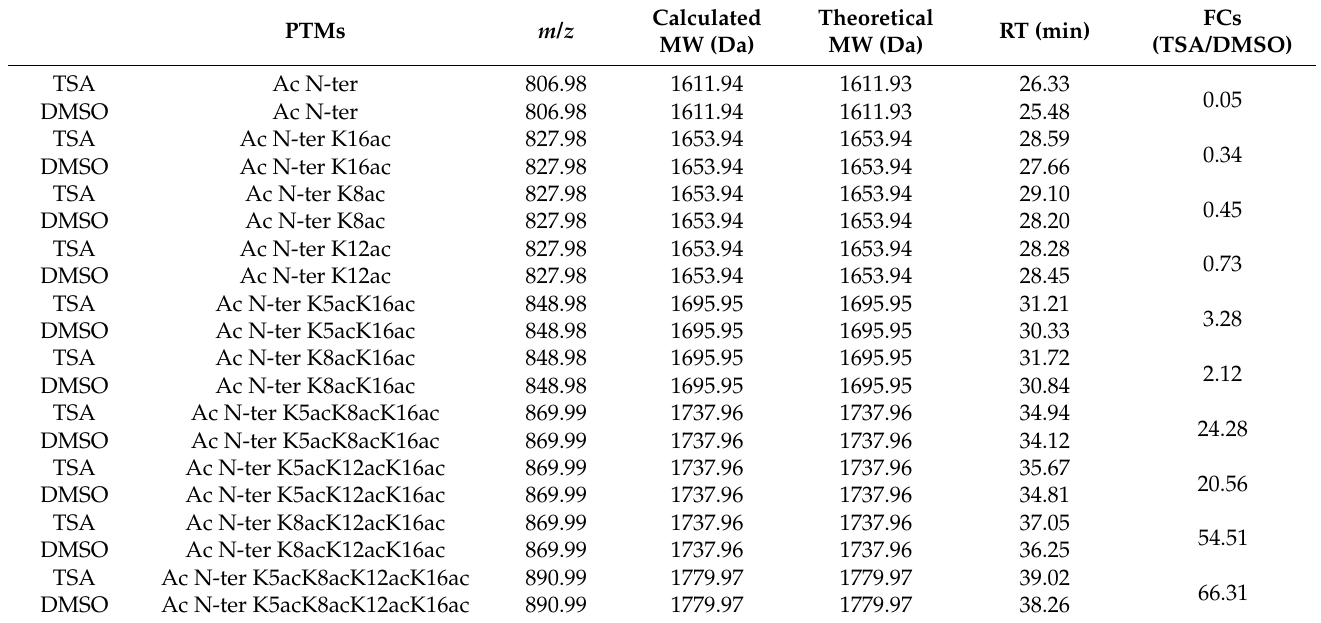
Figure 4. Extracted ion chromatogram (XIC) of selected peptides derived from histone H4 E14 ES mouse treated cells. The doubly charged 890.99 m / z signal corresponding to peptides 1–17 bearing five acetyl groups and reference peptides 46–55 are reported in DMSO- ( A ), and TSA ( B )-treated cells. The 869.99 m / z values relative to doubly charged peptides 1–17 carrying four acetyl groups are reported. ( C ) Extracted ion chromatogram recorded for DMSO-treated sample. ( D ) Extracted ion chromatograms recorded for TSA-treated in TSA K5K8K16 (RT: 34.94 min), K5K12K16 (RT: 35.67 min), K8K12K16 (RT: 37.05 min) are detected as separate forms in TSA-grown cells. N-terminus is always modified by acetyl group, and reference peptide is also reported. Peptide 1–17 sequence is reported upper in figure; in red K residues are highlighted, as potential targets of acetylation, in addition to the N-terminus. Ac: acetyl group. Table 1. Results of LC-MS/MS analysis of H4 1–17 peptide: post-translational modifications (PTMs), m / z signal, calculated and theoretical molecular weight (MW), retention time (RT), and peptide fold change (FC) are reported for each